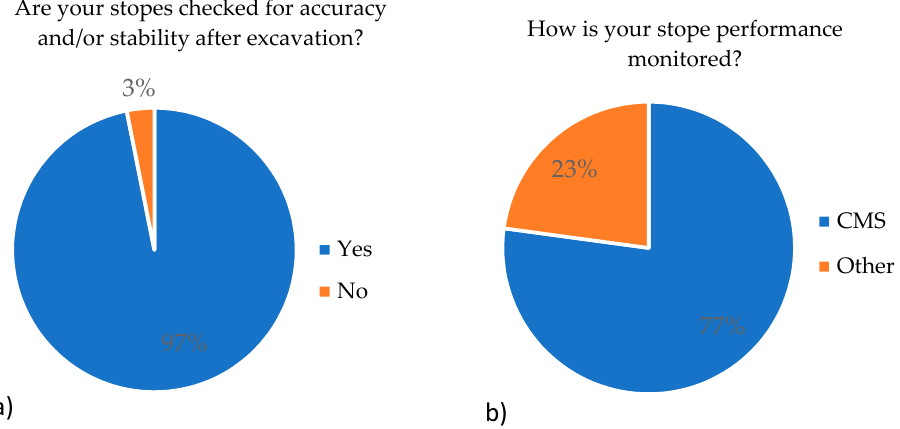
Figure 10. The application of stope performance and control after excavation takes place ( a ) including the cavity monitoring system (CMS) to measure the stopes ( b ).